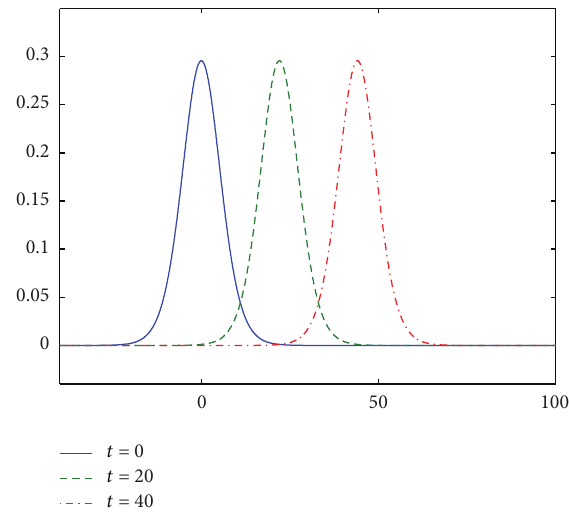
Figure 1: When 𝛼 = 1 and 𝜏 = ℎ = 0.05 , a numerical simulation figure on 𝑢(𝑥,𝑡) of Scheme I at various